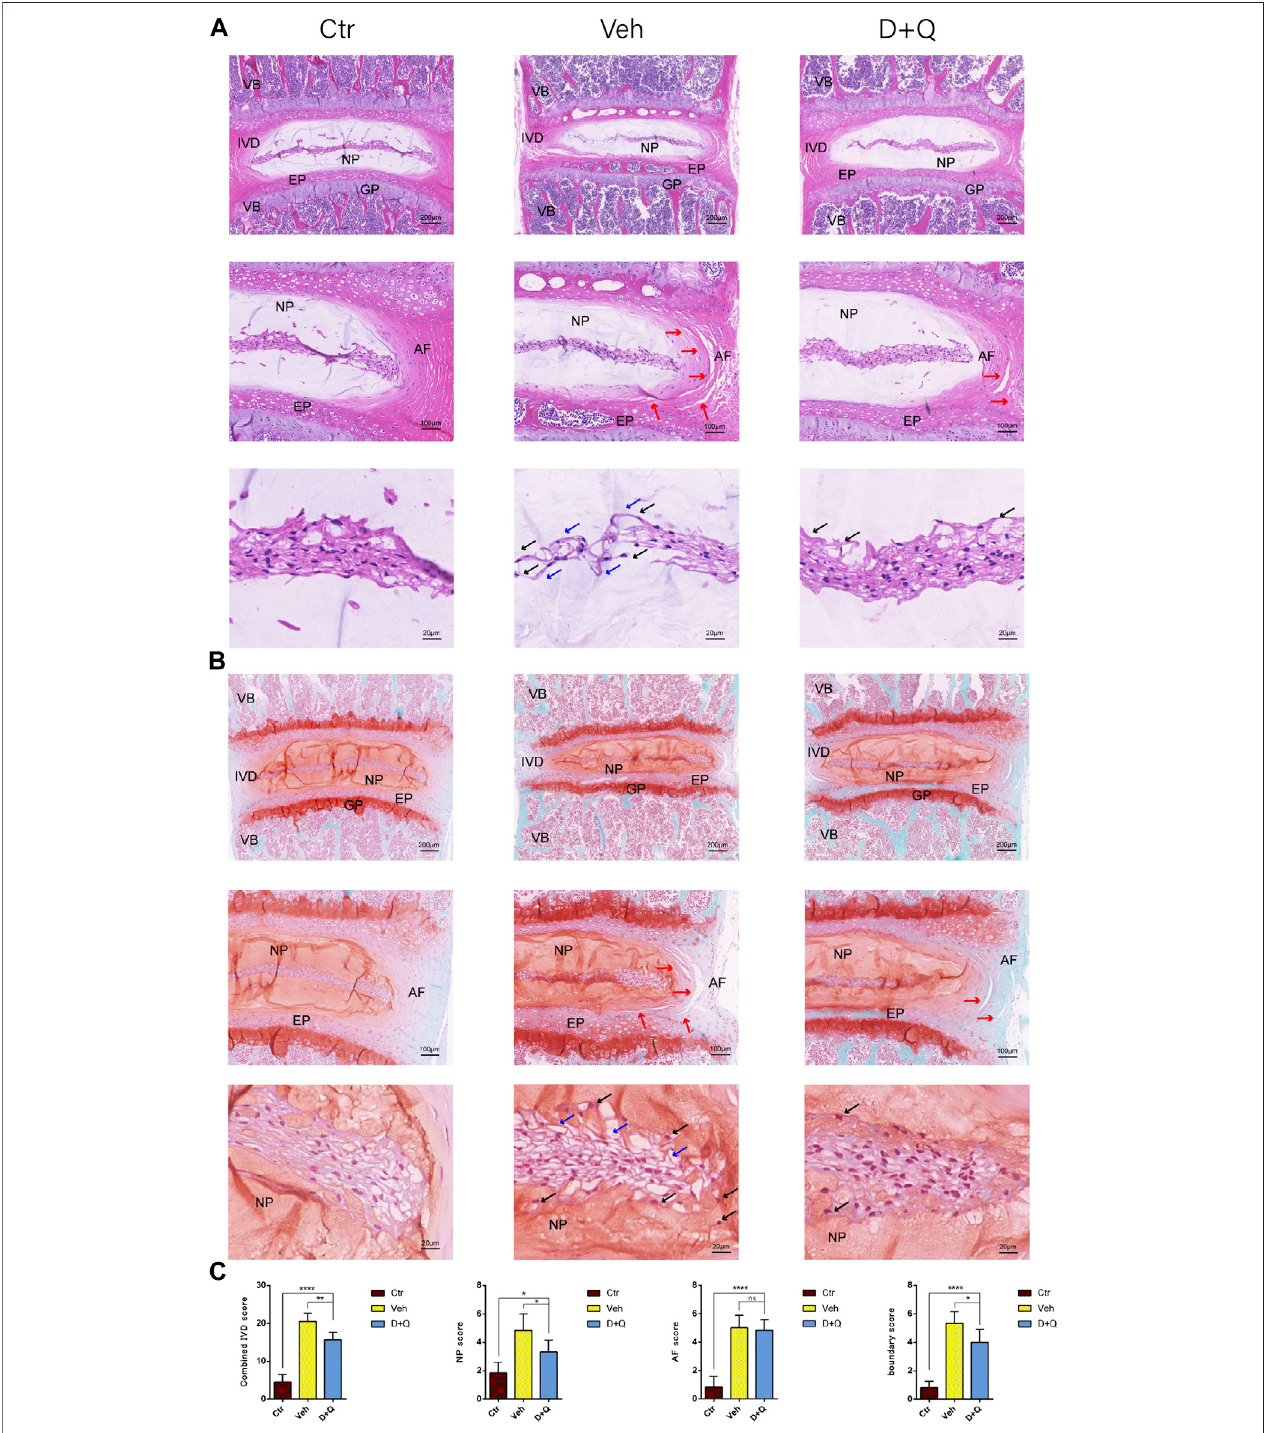
FIGURE3| Histologicalevaluation ofintervertebraldiscdegeneration. (A) Coronal sections ofIVDstainedbyhematoxylin andeosininCtr, Veh,and D+Qgroups. PanoramicimagesofIVDpathologyandhighermagni fi cationoftheannulus fi brosus(AF),endplate(EP),andnucleuspulposus(NP).IncreasednumberoftrapsinAF(red arrow), rare fi brous located between NP cells (blue arrow) and cluster of small and rounder NP cells (black arrow). (B) Coronal sections of IVD and endplate stained by safraninO-fastgreenin Ctr, Veh, and D+ Qgroups. Red indicates proteoglycan and green stains calci fi edcavities. Panoramic images ofIVDpathology and higher magni fi cation of the AF, EP, and NP. Loss of NP-AF boundary (red arrow), rare fi brous located between NP cells (blue arrow) and cluster of small and rounder NP cells (black arrow). (C) Combined IVD score, NP score, AF score, and AF/NP/EP boundary score of Ctr, Veh, and D + Q groups. IVD, intervertebral disc; EP, endplate; Ctr, controlgroup;Veh,vehiclegroup;D+Q,dasatinibandquercetingroup;scalebar=200 μ m(upper),100 μ m(middle),50 μ m(lower);D+Qvs.CtrgroupandVehgroup; ns, no signi fi cance; * p < 0.05; ** p < 0.01; *** p < 0.001; **** p < 0.0001.